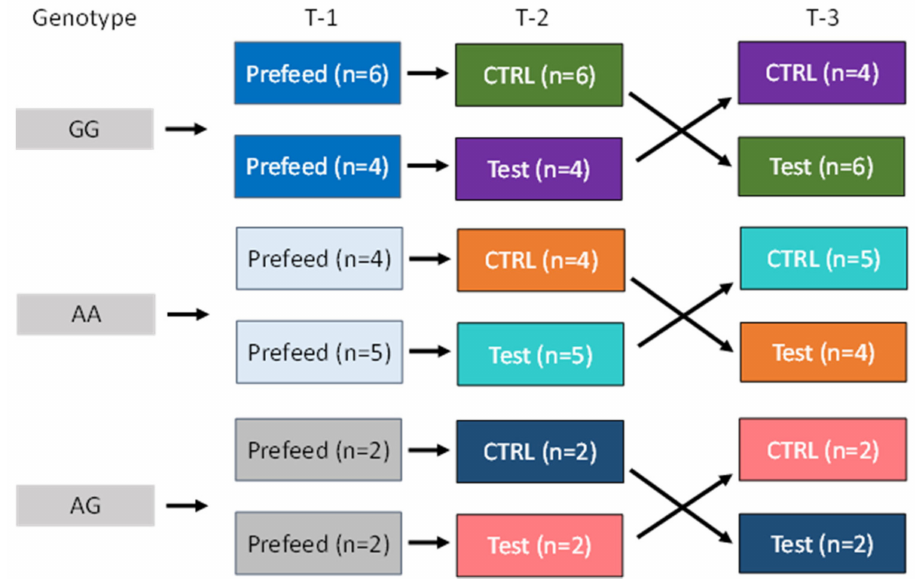
Figure 1. Cats with three alanine-glyoxylate aminotransferase 2 (AGXT2) single nucleotide polymor- phisms (SNPs: GG, AG, and AA) were fed control food for 28 days (Prefeed; T-1). Cats within each genotype were then split into two groups and fed control (CTRL) or test food in a cross over study design for 28 days each (T-2 and